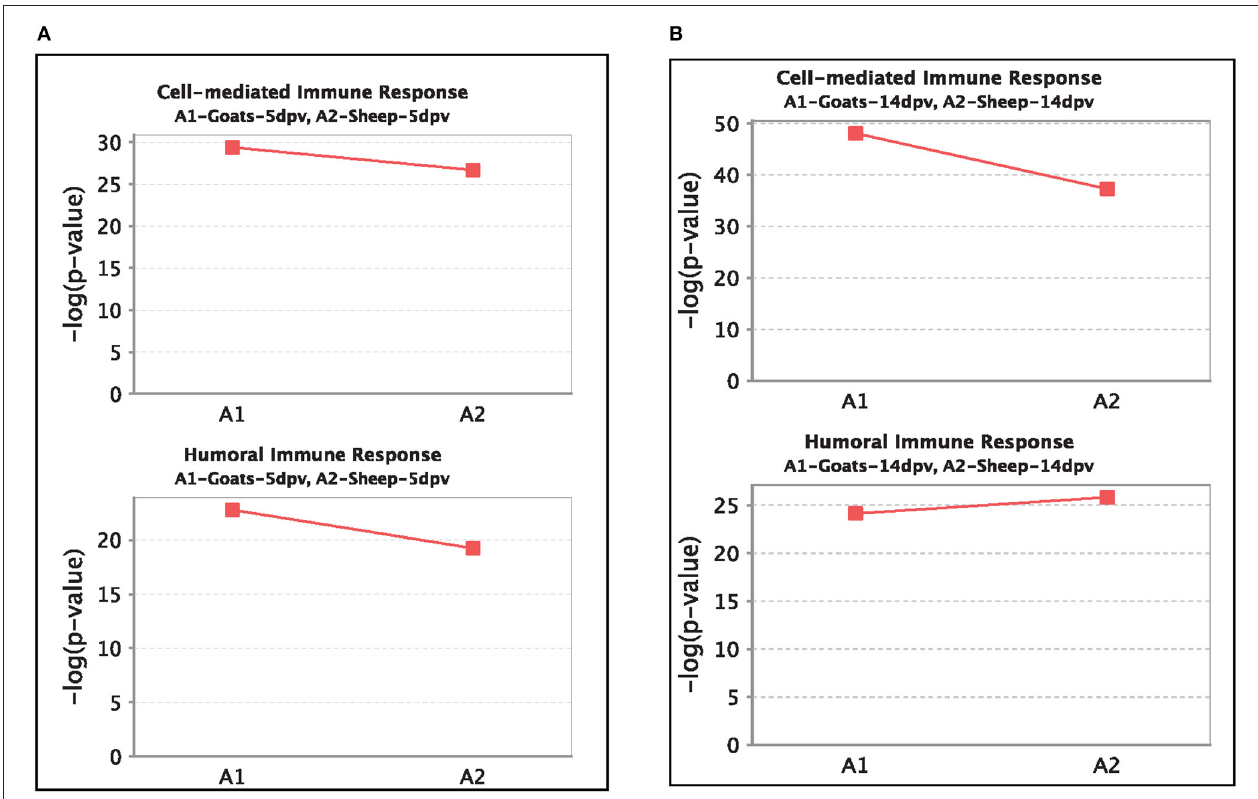
FIGURE 8 | Comparison of significant enrichment (–log p -value) of proteins in cell-mediated immune response and humoral immune response bio functions between vaccinated sheep and goats at (A) 5 days post-vaccination (dpv) and (B) 14